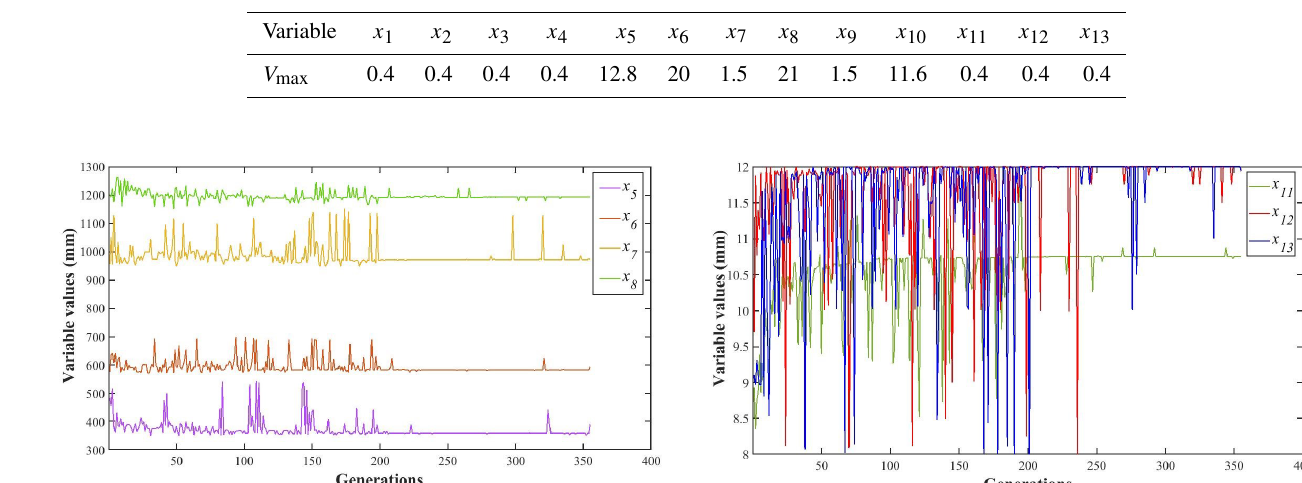
Table 7. Maximum search speed of the improved particle swarm algorithm.